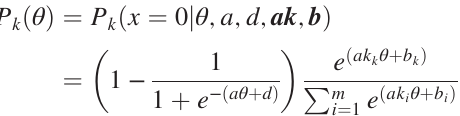
(purple, dot-dashed line) in Fig. 1; the item difficulty for option D is − 0 . 194 and the item discrimination is 2.56. The “ 0 ” along the ability axis is set to be the mean of the students ’ ability scores (i.e., the scale is student centered).